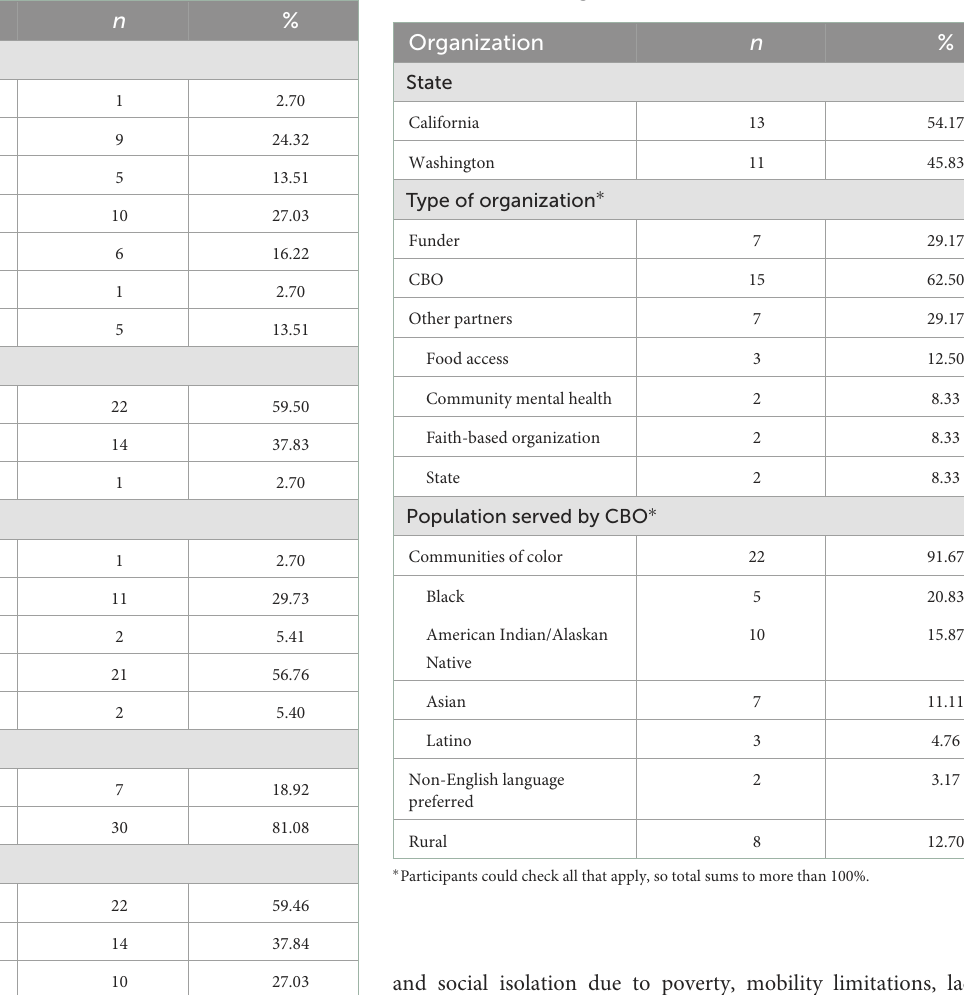
TABLE 2 Characteristics of interview participants ( N = 37) a . TABLE 3 Participating organizations that reach older adults who are underserved in Washington and California ( N =